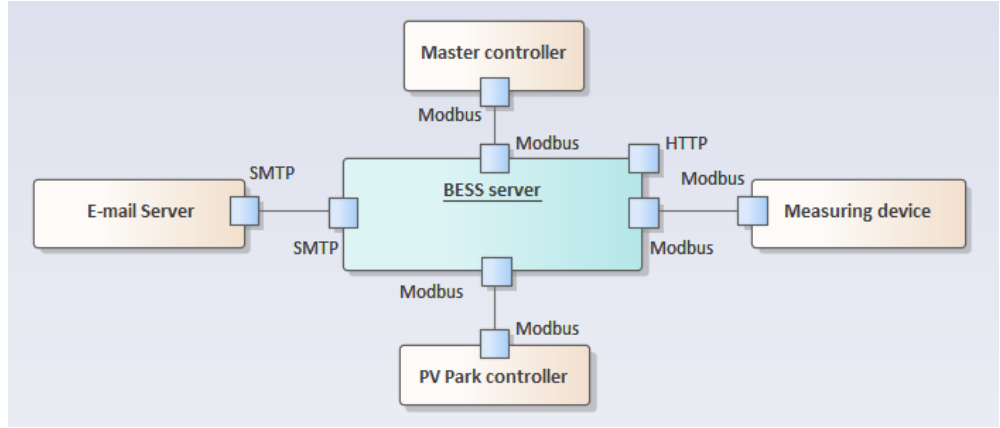
Figure 3. Diagram of control and data recording systems in the supervision system considered.